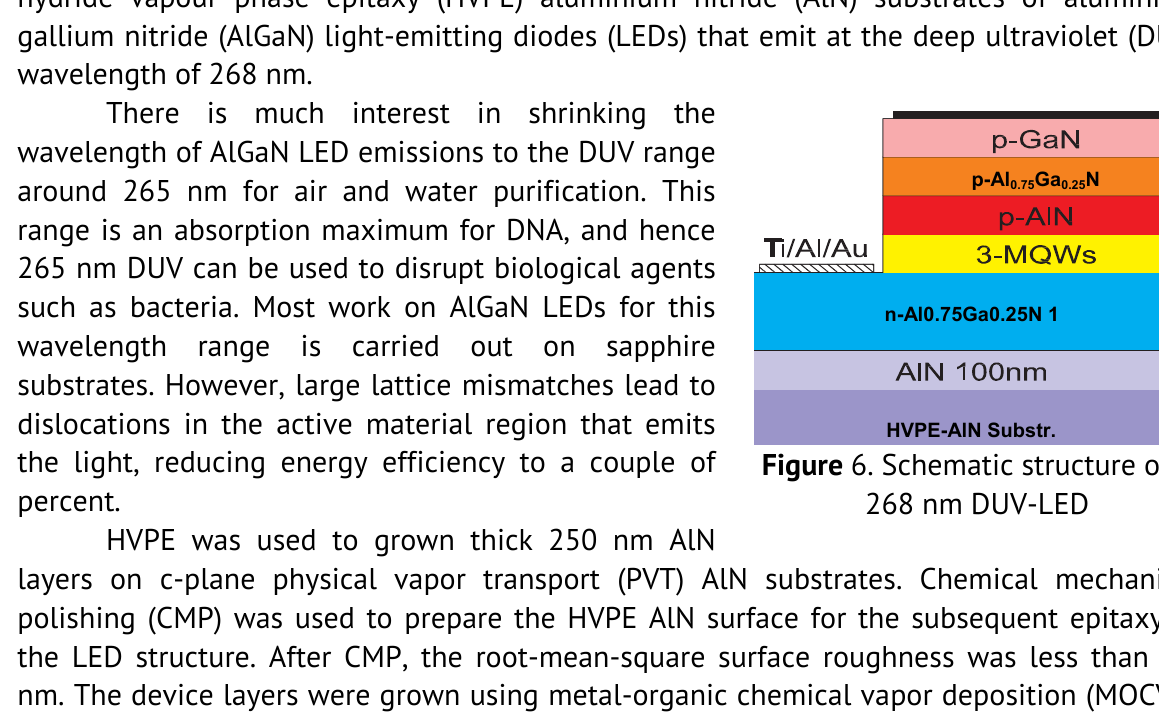
n-Al0.75Ga0.25N 1